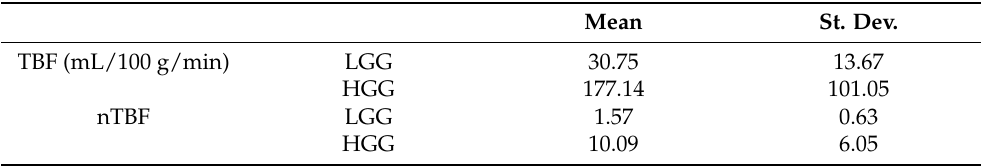
Table 2. Mean values of tumor blood flow and normalized tumor blood flow in low- and high-grade gliomas.